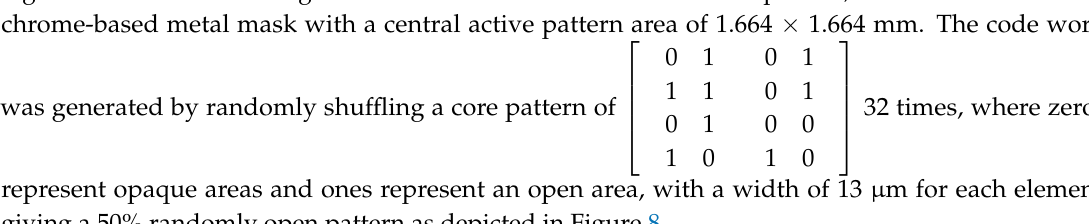
Figure 7. Samples of 3D targets for testing: ( a ) RGB presentation. ( b ) Spectral reflectance characteristics of the three targets.